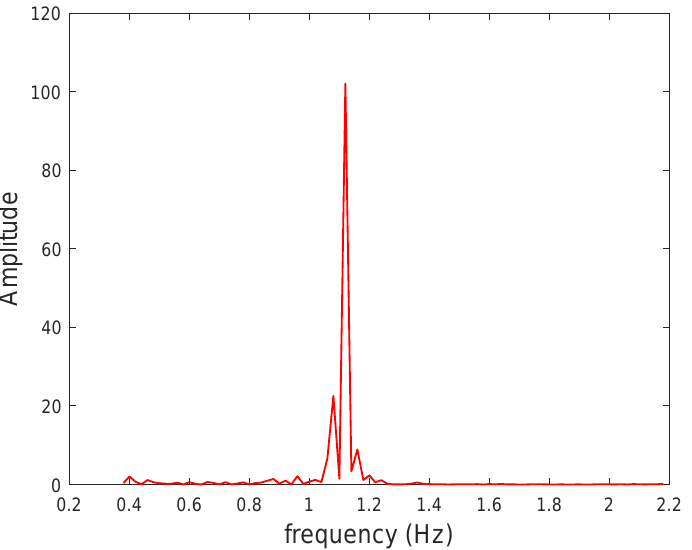
Figure 4. Typical FFT spectrum from a smoothed mean intensity signal (red channel). The estimated pulse rate is 67 bpm (1.1195